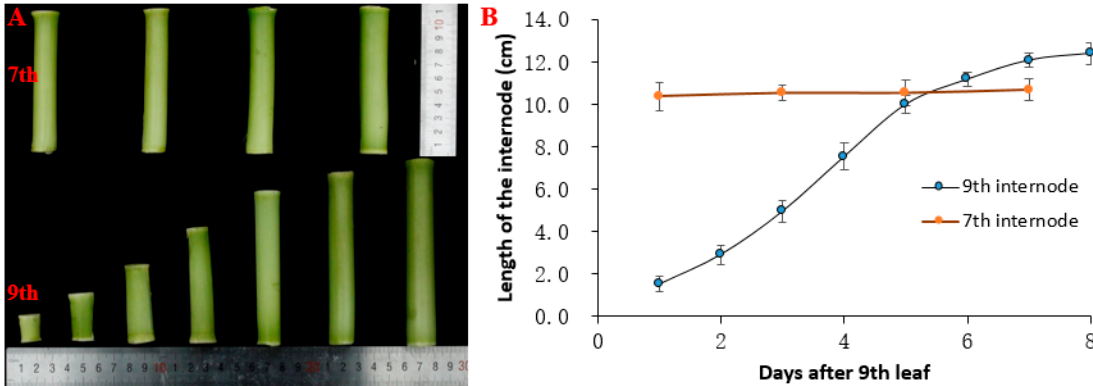
Figure 1. Changes in the length of the seventh and ninth internodes. ( A ) Phenotypes of seventh and ninth internodes length in B73. The bottom half shows the phenotype of the ninth internode from day 1 to day 7 after nine leaves of maize were unfolded. The top half shows the phenotype of the seventh internode on day 1, 3, 5, and 7 after nine leaves of maize were unfolded. ( B ) Elongation curves of the seventh and ninth internodes after nine leaves of maize were unfolded. The blue dots from left to right indicate the length of the ninth internode from day 1 to day 8. The orange dots from left to right indicate the length of the seventh internode on day 1, 3, 5, and 7 after nine leaves of maize were unfolded. Values are means ± SE of four biological replicates. The data are presented in Supplementary Table S1.